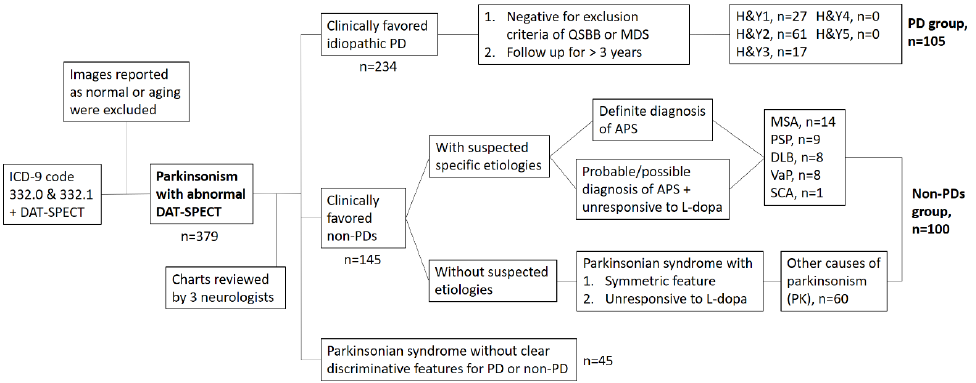
Figure 1. The flow chart of subject selection for artificial neural network (ANN)-classifier training. The cases with drug-induced parkinsonism which reported as normal DAT-SPECT were excluded. ICD, international classification diagnosis; DAT-SPECT, dopamine transporter single-photon emission computed tomography; PD, Parkinson’s disease; APS, atypical parkinsonian syndrome; QSBB, Queen Square Brain Bank; MDS, movement disorder society; H&Y, Hoehn and Yahr stage; MSA, multiple system atrophy; PSP, progressive supranuclear palsy; DLB, dementia with Lewy bodies; VaP, vascular parkinsonism; SCA, spinocerebellar ataxia.